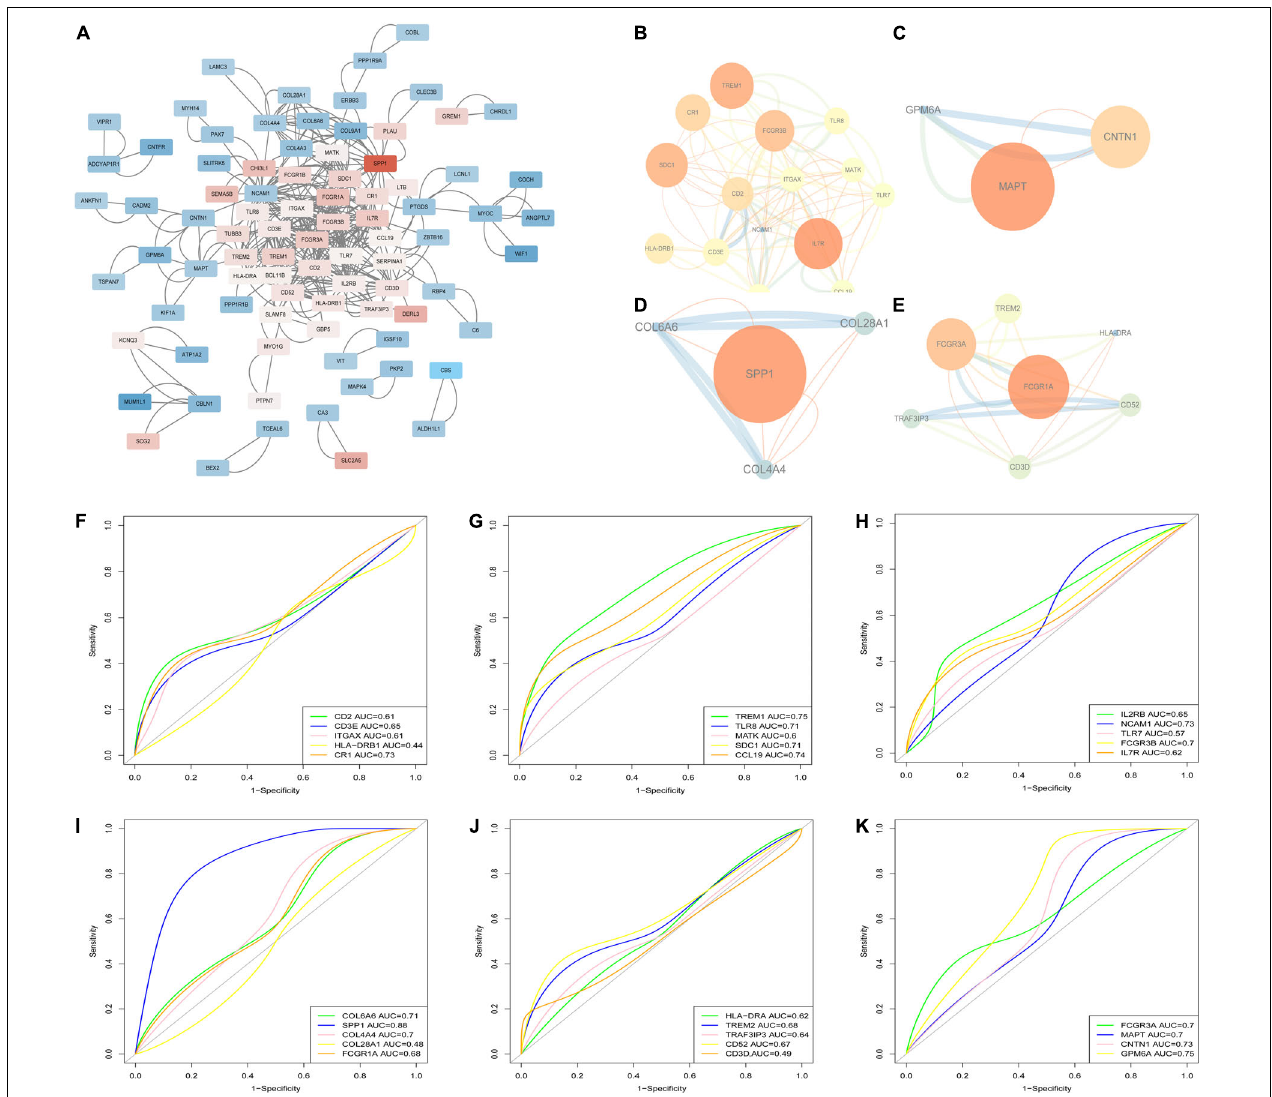
FIGURE 6 | PPI network and hub genes identification. (A) The PPI network of DEGs; (B–E) The four sub-networks of the PPI network; (F–K) Receiver operating characteristic curve (ROC) for the genes in sub-networks in